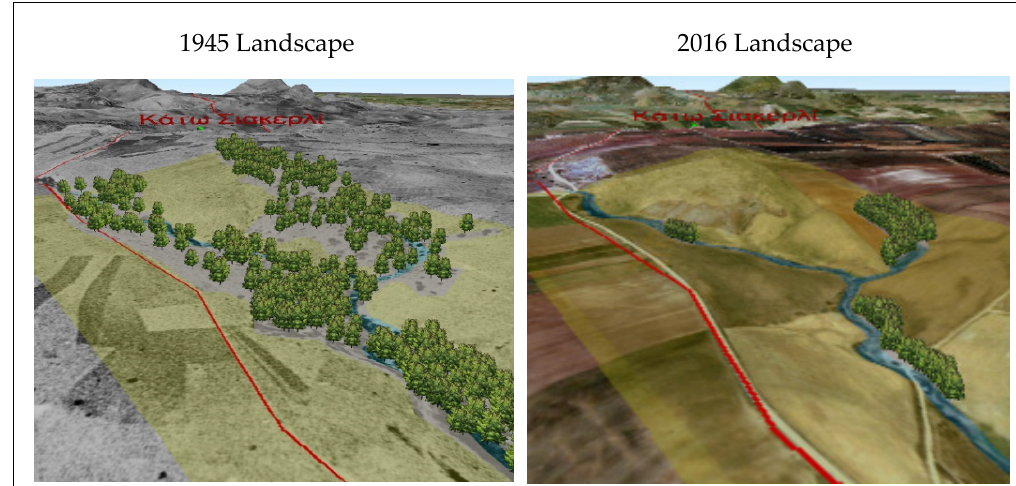
Figure 10. 3D Representation of the changes in the landscape in 1945 and 2016, respectively.